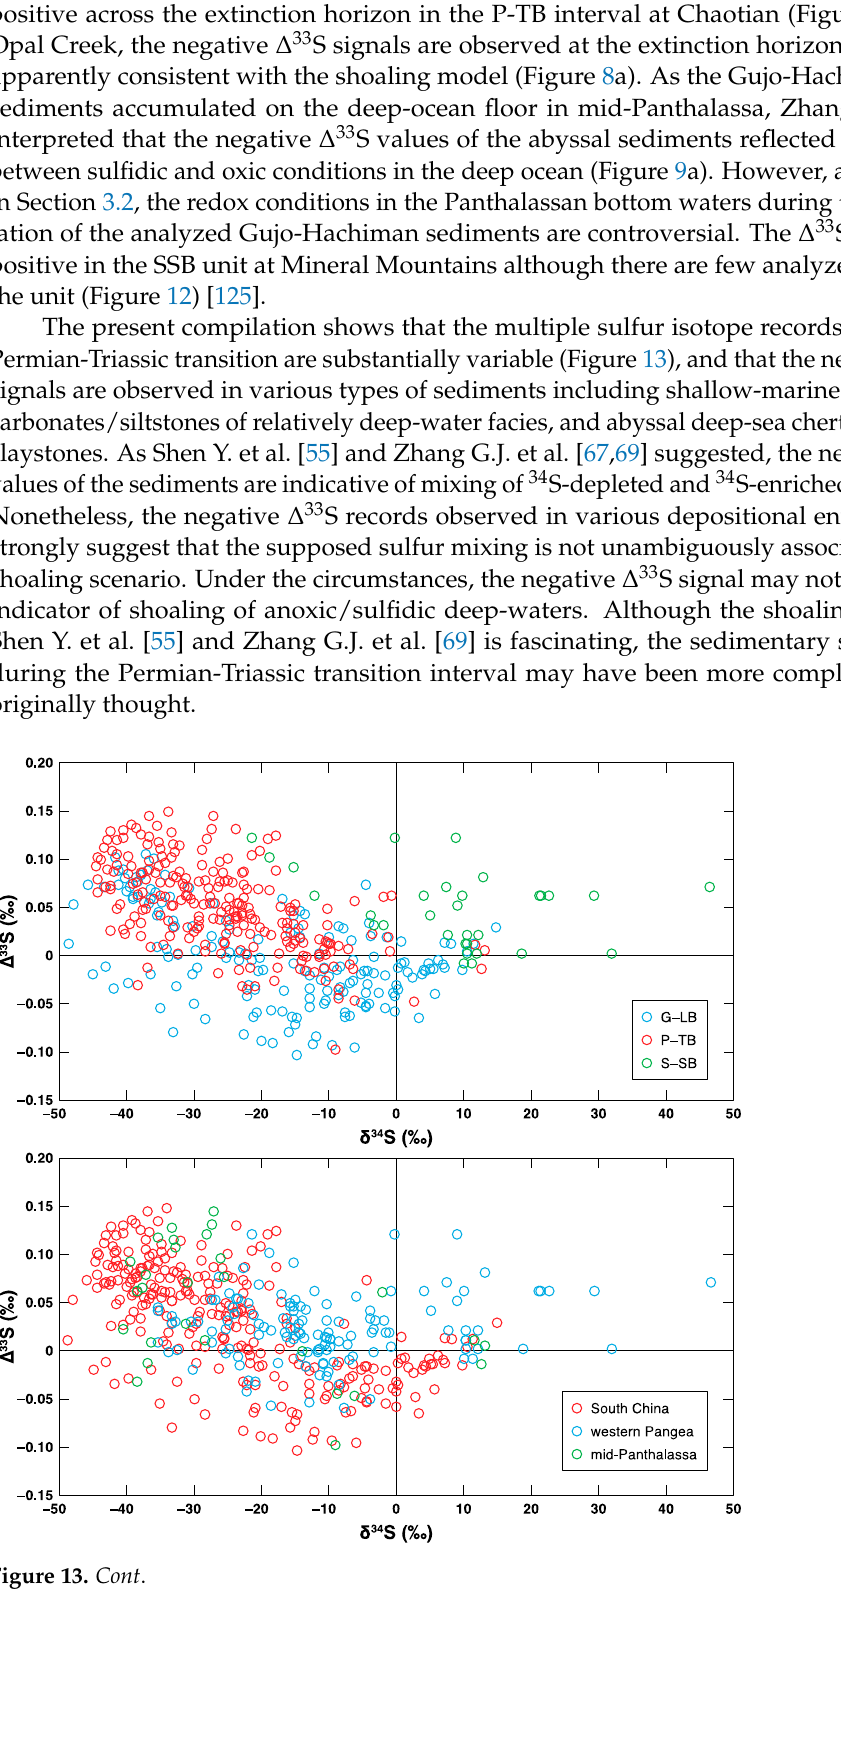
Figure 13. Multiple sulfur isotope records during the Permian-Triassic transition interval. Note that the negative ∆ 33 S signals were detected in various types of sediments.